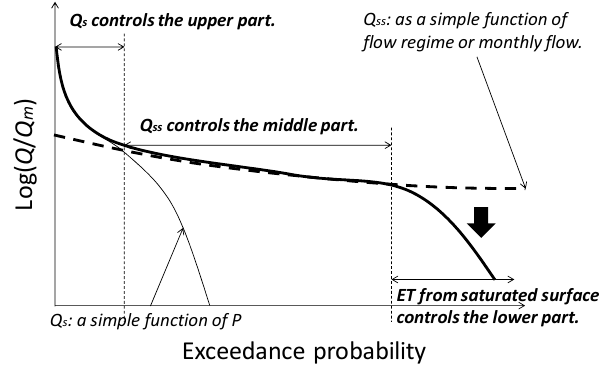
Fig. 7. Schematic illustrating the understanding gained through this simulation study regarding the shapes of the flow duration curve, including the controls on the different parts of the FDC.